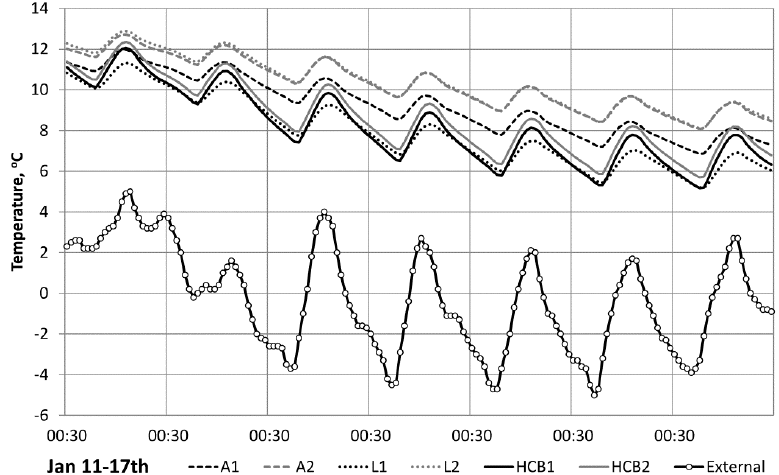
Figure 5. Outdoor temperature and indoor room temperatures for different wall constructions, for a seven day winter period.